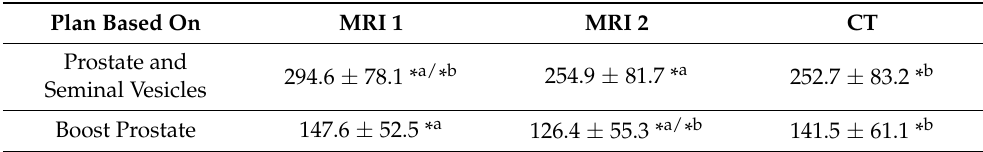
Figure 1. The volume of the prostate decreased significantly under ADT. PTV1 (prostate and seminal vesicles) decreased significantly, on average, by 14% after ADT from 295 cm 3 on MRI 1 to 255 cm 3 on MRI 2. The boost PTV2 decreased significantly, on average, by 15% after ADT from 148 cm 3 on MRI 1 to 126 cm 3 on MRI 2. For further details, see Table 3. Table 3. Size of PTV [cm 3